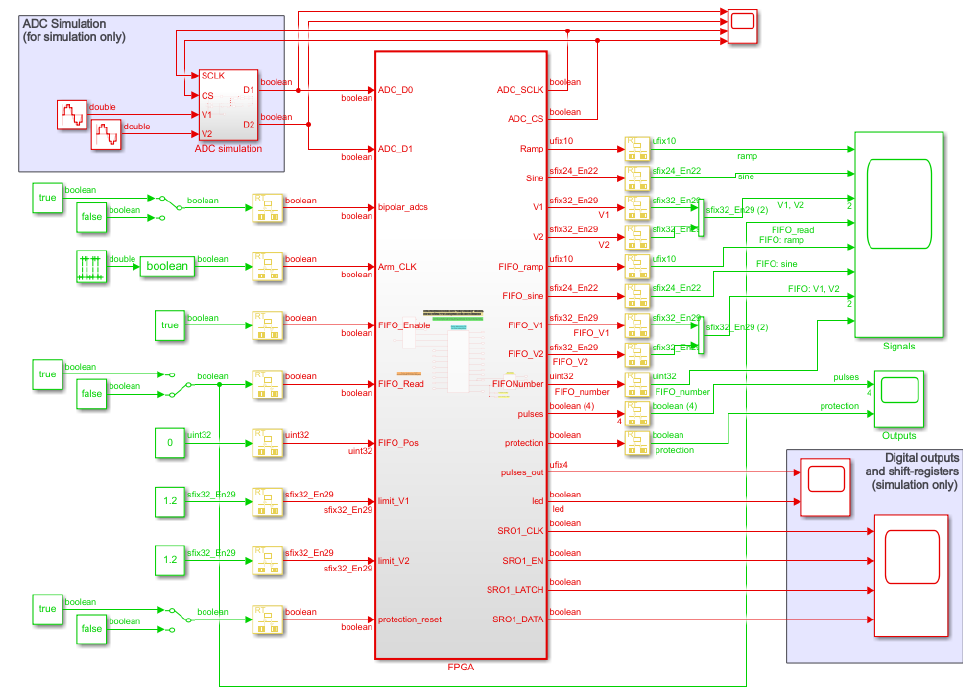
Figure 7. Top-level view of the demo model provided in [34]. Red and green represent the sampling times of the FPGA and processor,